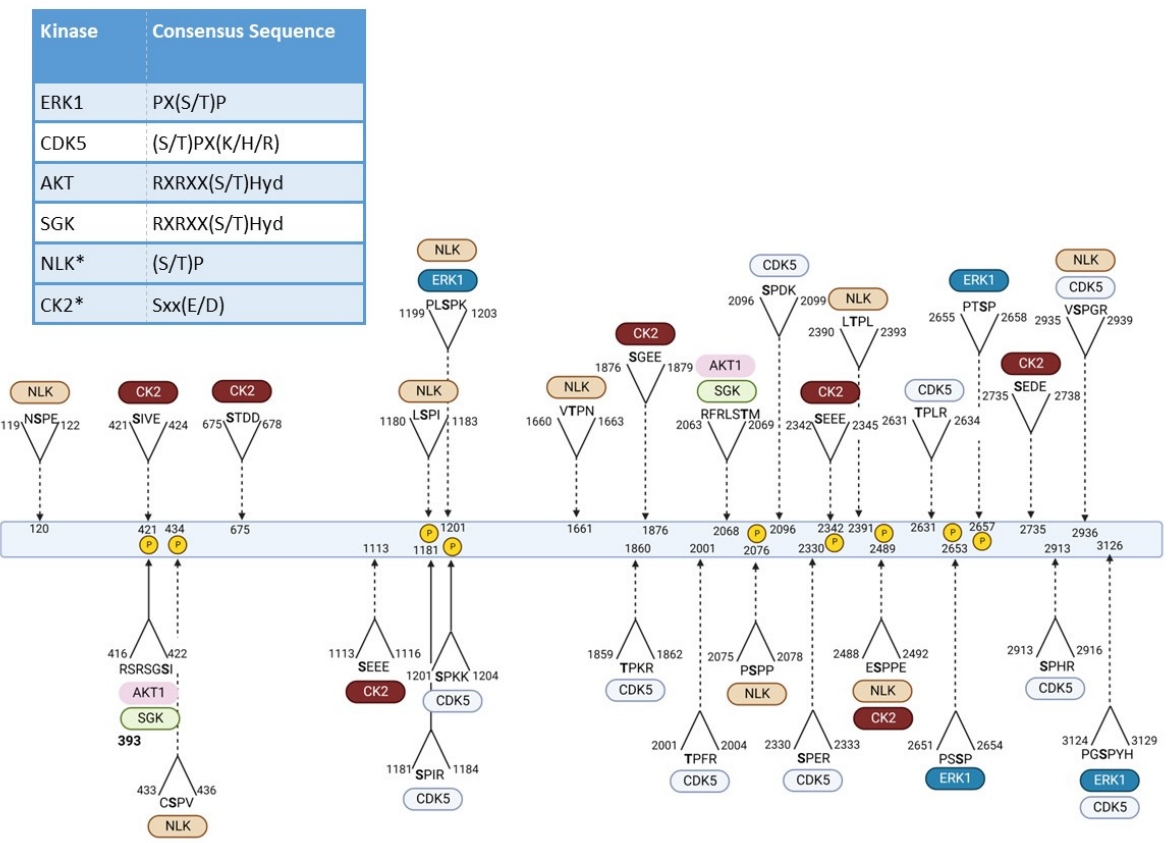
Figure 2. Identified kinase consensus sites along HTT. Consensus sites for ERK1, CDK5, AKT, SGK, NLK and CK2 are shown in top left panel [120–125]. IKK or TBK1 were not included due to the lack of well-defined consensus phosphorylation sequences for these kinases. Putative phosphorylation sites were identified for several kinases implicated in HTT phosphorylation along HTT and confirmed via https://www.phosphosite.org/ (accessed 9 August 2022) [126]. * CK2 and NLK returned 25+ putative sites and only those nearby previously identified phosphorylation sites or in critical protein regions are shown. For CK2 only sites that did not include R, K or P at the +1 position and at least 2 D or E’s in the sequence were included [127]. For NLK, only those sites that better aligned with the phosphosite Sequence logo were included. Putative kinase sites were then identified on HTT using https://www.bioinformatics.org/sms2/protein_pattern.html (accessed 9 August 2022) [128], using human HTT as reference (NCBI NP_002102.4). Putative sites for which phosphorylations have been identified are marked with a yellow P and details for these sites can be found in Table 2. Dashed lines indicate a kinase identified via this consensus sequence, but no evidence connecting the kinase to the site yet. Solid line indicates that the consensus sites were identified in regions where phosphorylation has been confirmed, with the kinase implicated in mediating the phosphosphorylation. Created with Biorender.com (accessed 10 August 2022).